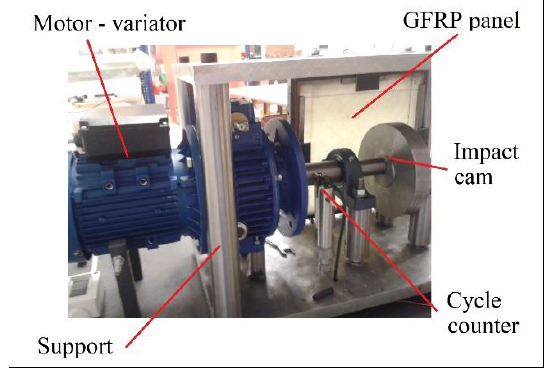
Figure 2. Reproduction equipment for slamming impacts.